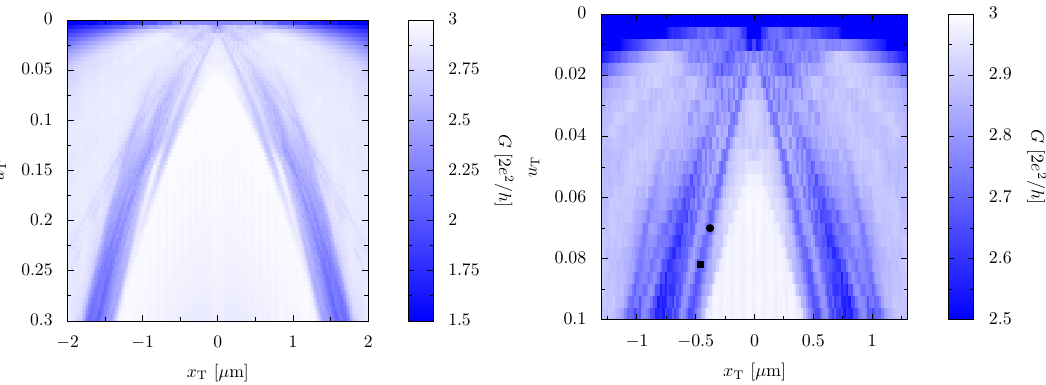
Figure 12: Classical conductance through a clean cavity calculated from exact tra- jectories in a 1 / r 2 -shaped tip potential. The right panel shows a zoom around the origin of the left panel using a more sensitive colorscale in order to highlight the details. The circle and the square indicate parameter choices for which the reflected trajectories are shown in Fig. 13.